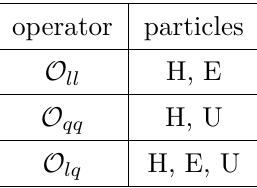
Table 11. Particle content for minimal models for O ll , O lq and O qq